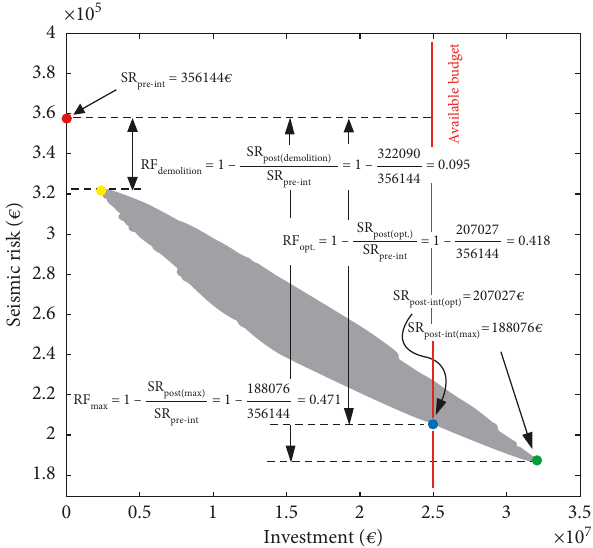
F IGURE 14: Investment and postintervention seismic risk for each of the 3.2 e 6 solutions. Identification of the optimal alternative is